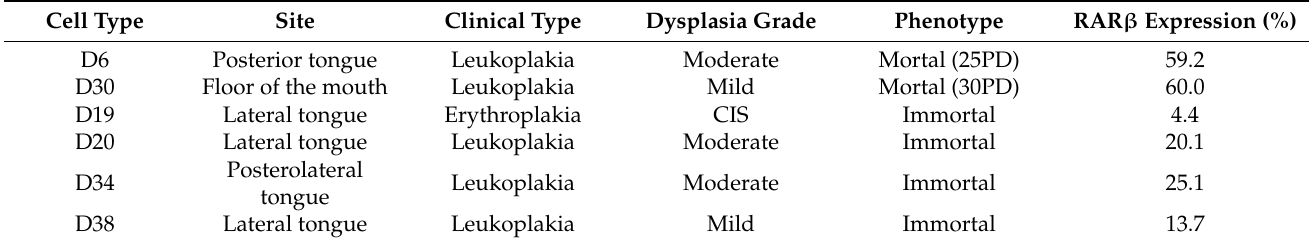
Table 1. Details of the PMOL cell lines used in the study with original diagnosis and expression of RAR β in the corresponding parent